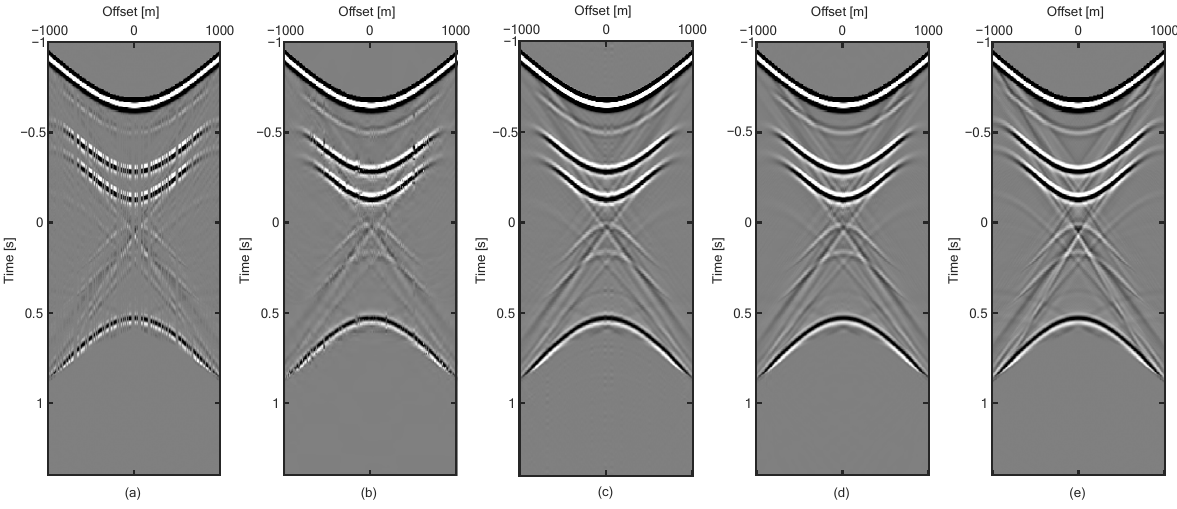
Figure 7. Comparison of focusing functions of the 100th iteration. ( a ) The focusing function without reconstruction, calculated by irregular sampling over the source dimension and integrating over the receiver dimension; ( b ) The reconstructed focusing function for sparse reconstruction in the wavelet domain; ( c ) The reconstructed focusing function for sparse reconstruction in Fourier domain; ( d ) The reconstructed focusing function for sparse reconstruction in curvelet domain; ( e ) The focusing function for reference.